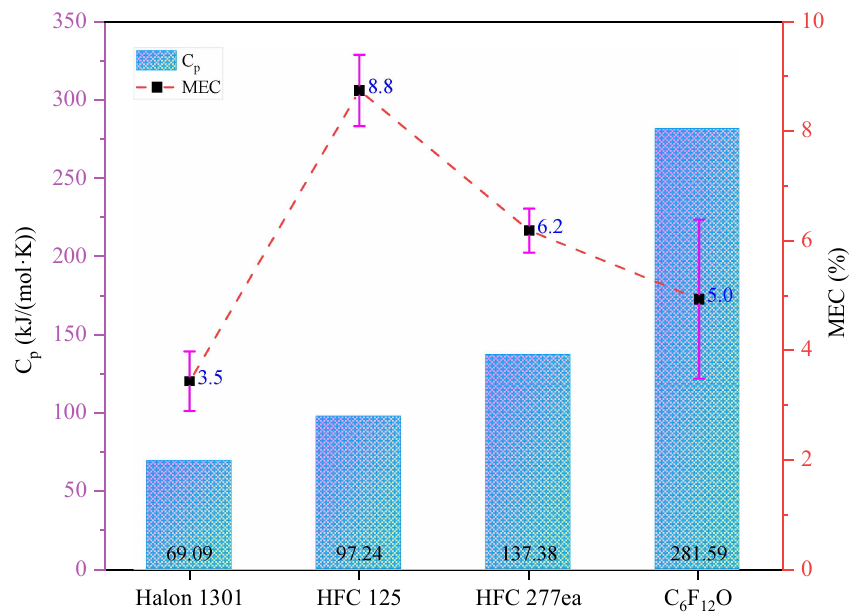
Figure 5. The comparation between the MEC (from Table 3) and the molar specific heat (C p ) of typical fire suppressants.